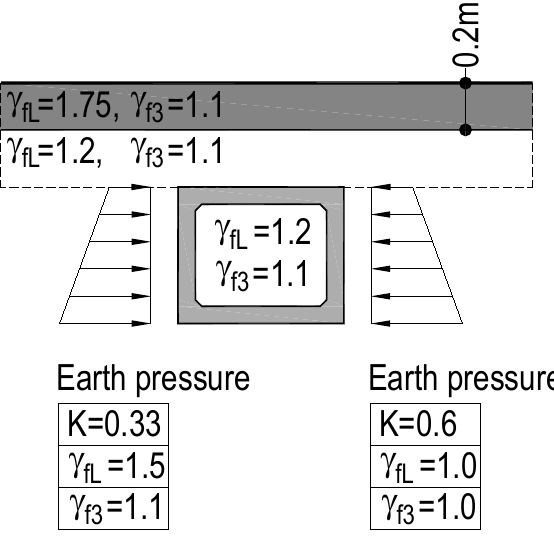
Figure 4: Partial load factors consistent with diagram A/4a [8].